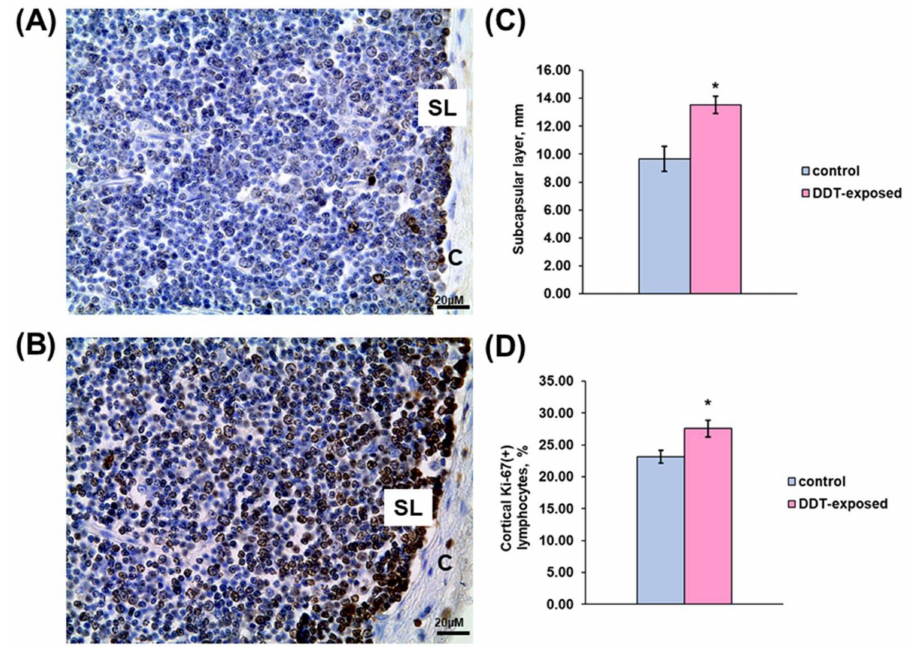
Figure 3. Immunohistochemical evaluation of Ki-67-positive cortical lymphocytes in prenatally and postnatally exposed to DDT and intact adult rats aged 10 weeks. Distribution of proliferating thymocytes in the control ( A ) and DDT-exposed ( B ) rats. C—capsule, SL—subcapsular lymphoblasts. Magnification 400, scale bar 20 µ m. Width of subcapsular layer of mitotically active lymphoblasts ( C ), percentage of Ki-67-positive thymocytes in the cortex ( D ). Data presents as mean ± S.E.M. p < 0.05 compared to the control